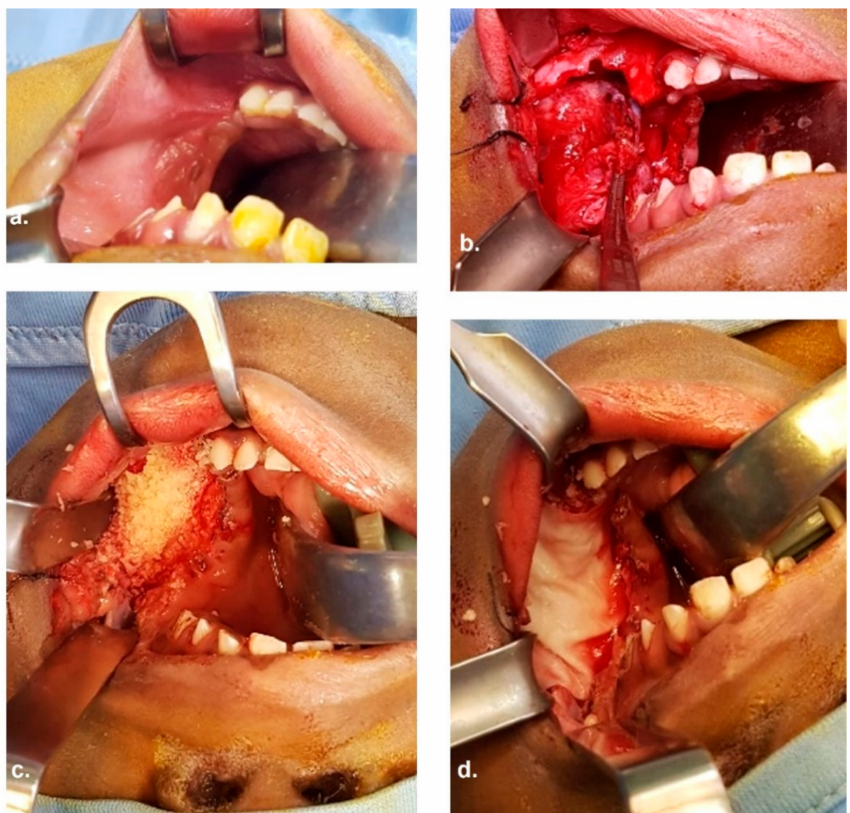
Figure 4. Intra-operative pictures. ( a ) Surgical field preparation; ( b ) en-bloc tumor enucleation after exposure of the body and left mandibular ramus. Note the clear cleavage plane between the fibrous tumor capsule and the bony cortical walls; ( c ) fresh-frozen bone allograft placement in the left residual mandibular bone defect; ( d ) a bilayered collagen membrane (Bio-Gide, Geistlich, Wolhusen, Switzerland) is placed to cover the bone allograft.